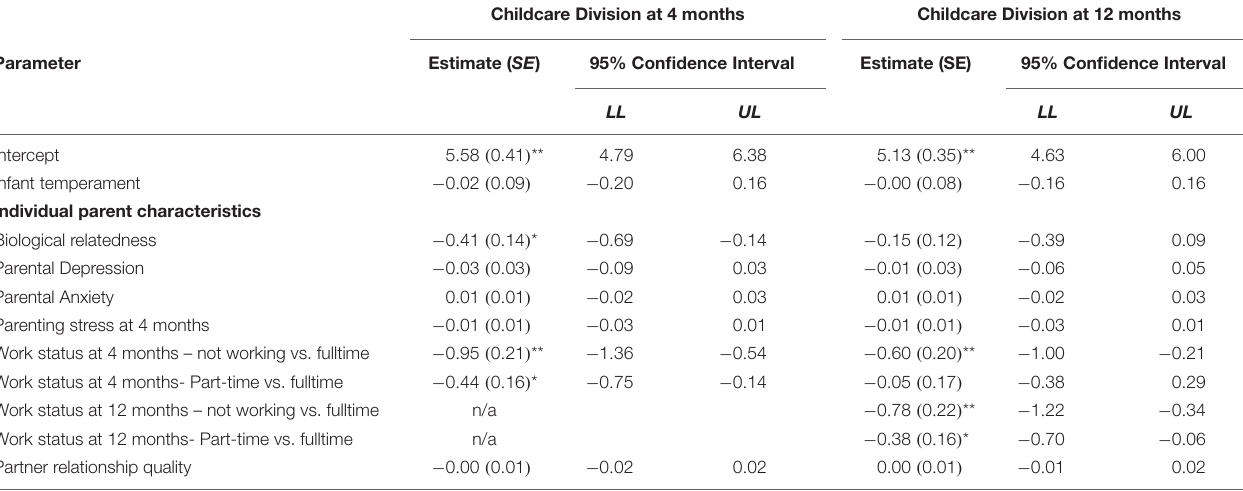
TABLE 4 | Fixed effects estimates of predictors of childcare